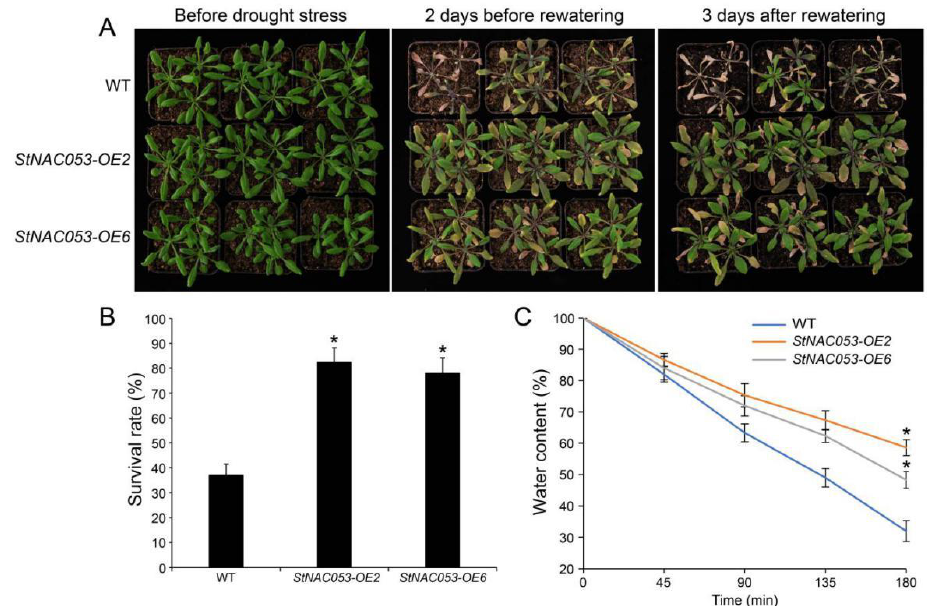
Figure 9. Transgenic StNAC053 Arabidopsis showed higher drought tolerance. ( A ) Phenotypes of StNAC053 overexpressing and wild-type Arabidopsis under drought stress. The StNAC053 overex- pressing and wild-type Arabidopsis were grown for four weeks under normal conditions. Watering was ceased for two weeks, followed by rewatering for recovery. ( B ) Statistical analysis of survival rates after three days for rewatering. ( C ) Water loss rates of detached rosette leaves of StNAC053 overexpressing and wild-type Arabidopsis . WT, wild-type. The data were means ± SD from three independent replications. * p < 0.05 ( t -tests).